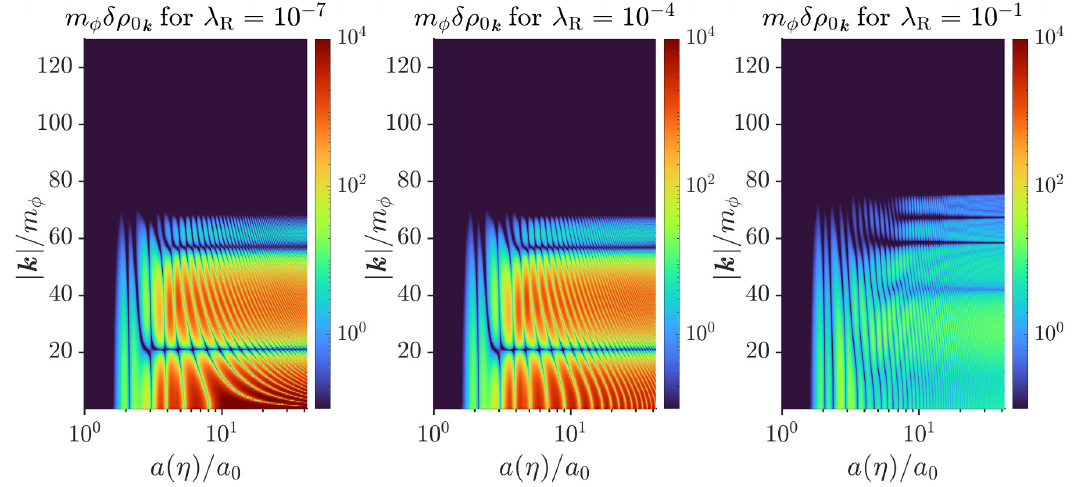
Figure 8 . The zeroth moment δρ 0 k of the two point function for λ R ∈ { 10 − 7 , 10 − 4 , 10 − 1 } with ¯ ξ R = 50 and Γ ' 0 . 1 H 0